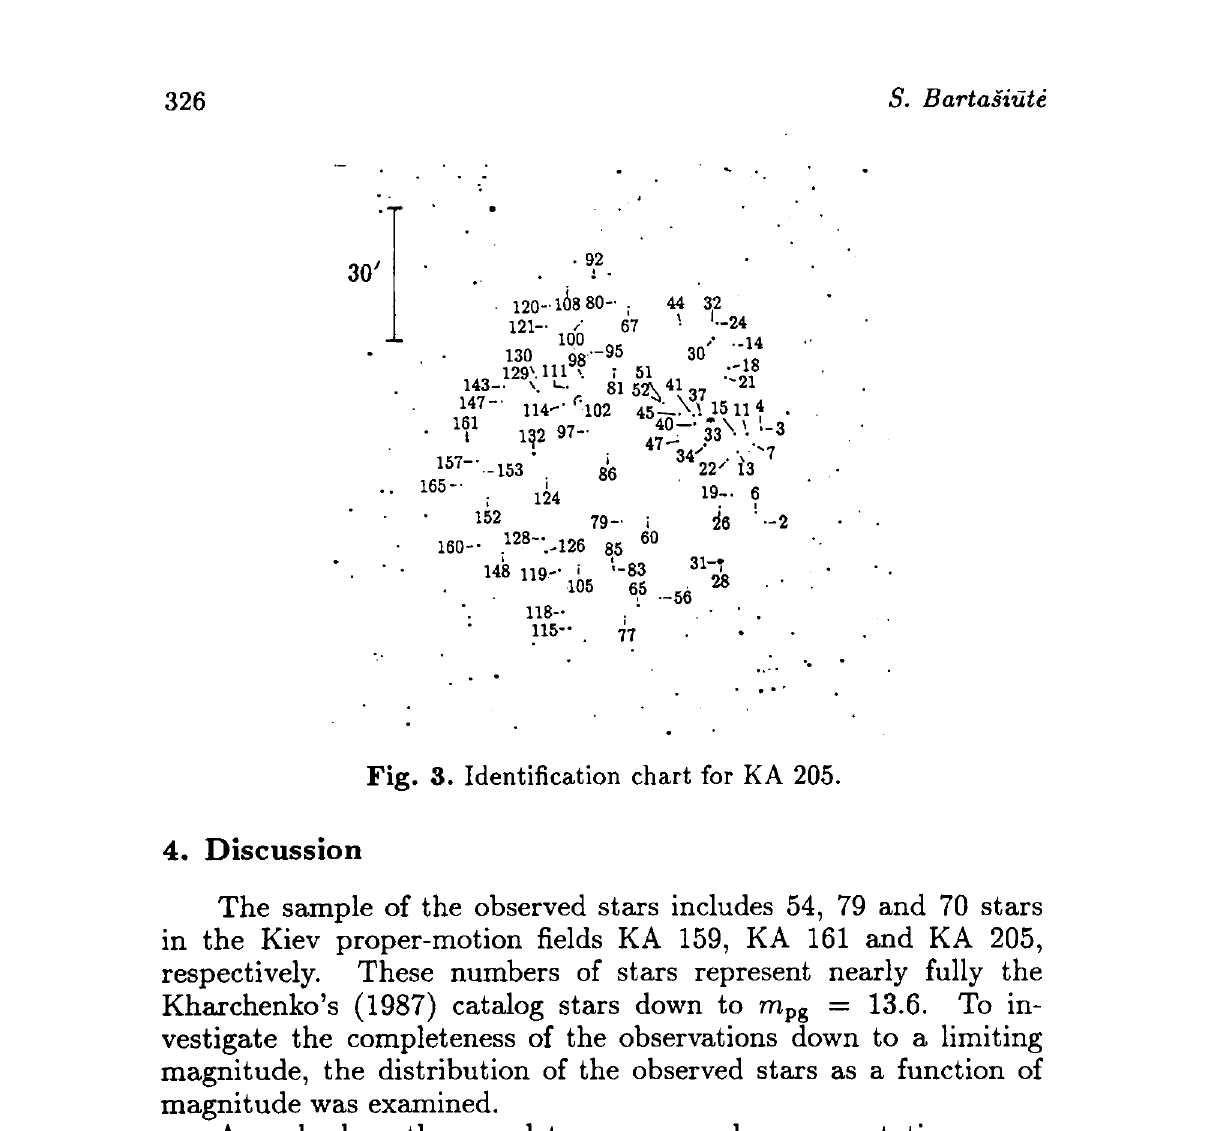
Fig. 3. Identification chart for KA